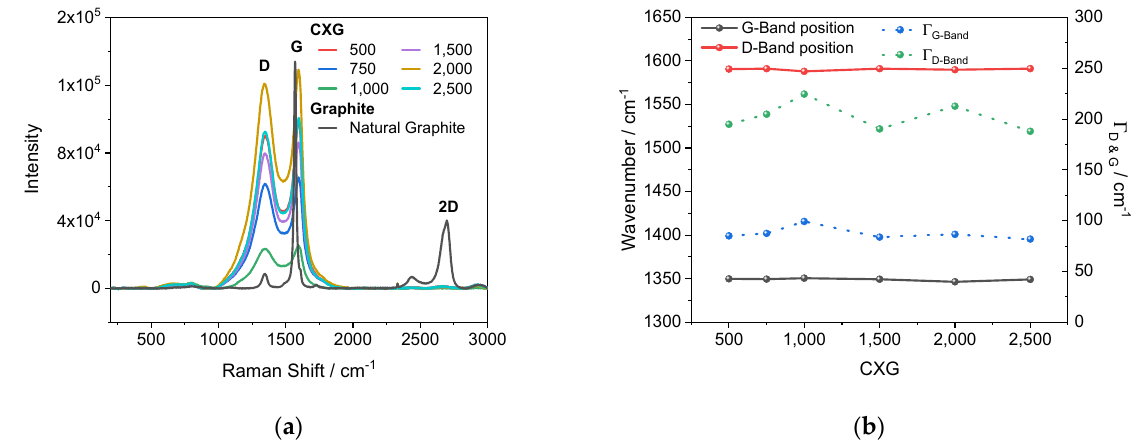
Figure 4. Raman spectra of selected CXG ( a ). Position of D and G-band as well as Γ D- and Γ G-band as a function of R/C value ( b ).